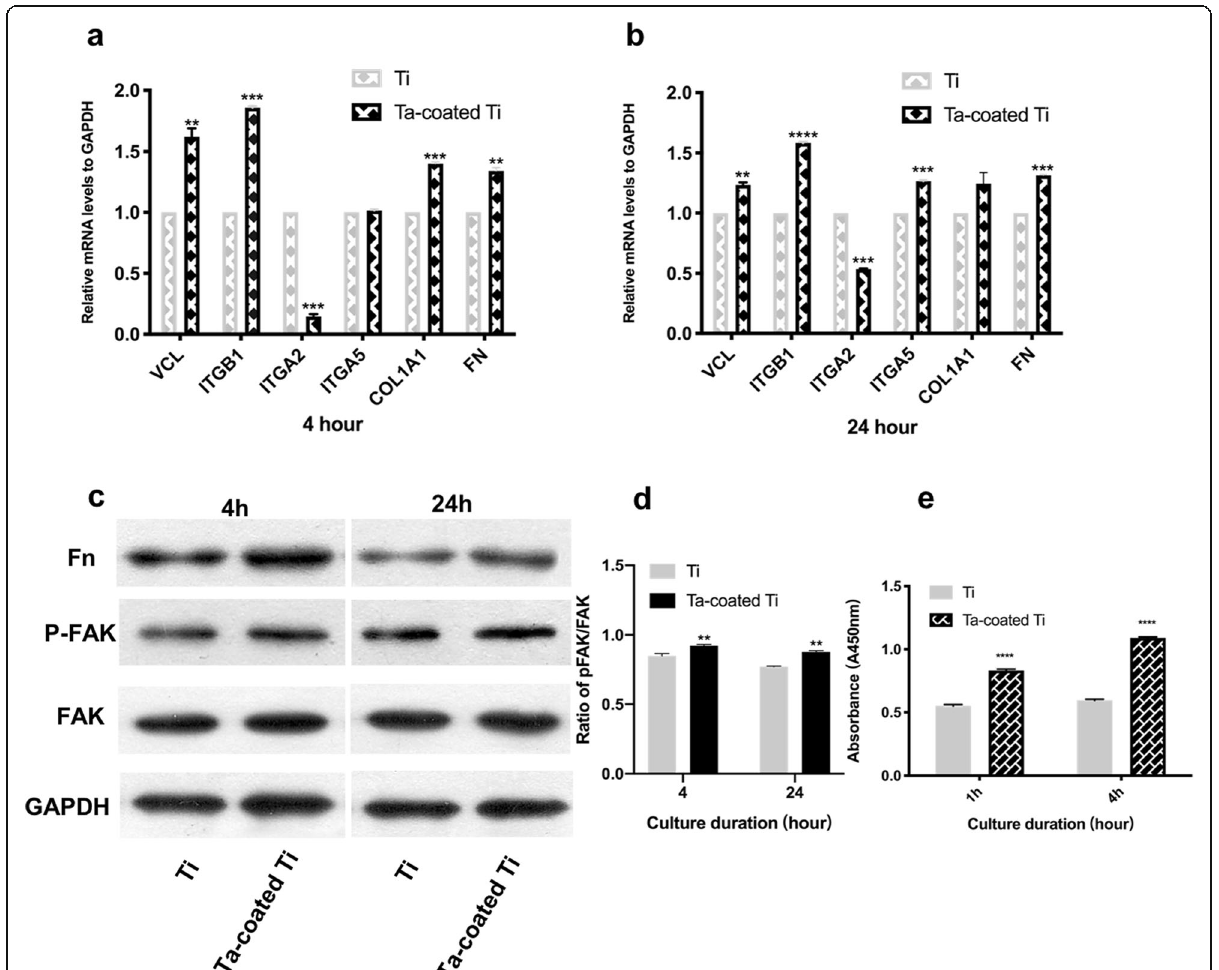
Fig. 7 a , b Real-time PCR detection of adhesion-related gene expression of HGFs on both samples at 4 and 24 h with statistical significance by ** p < 0.01, *** p < 0.001, **** p < 0.0001. c Western blot for signaling protein (FAK and pFAK) and Fn. d The expression ratio of p-FAK/FAK quantified by densitometry ( n = 3).** p < 0.01. e Increased fibronectin adsorption on Ta-coated Ti surface compared to Ti group (**** p <